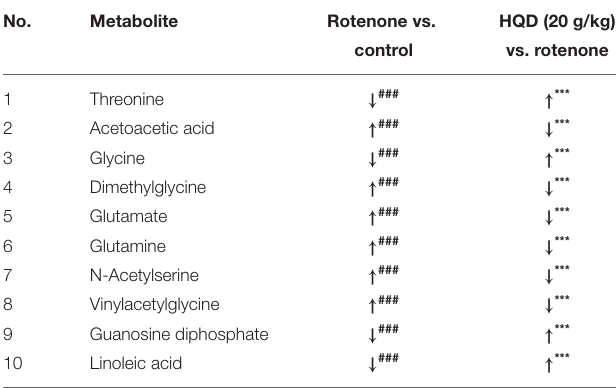
TABLE 3 | Differential metabolites regulated by HQD in rotenone-induced PD